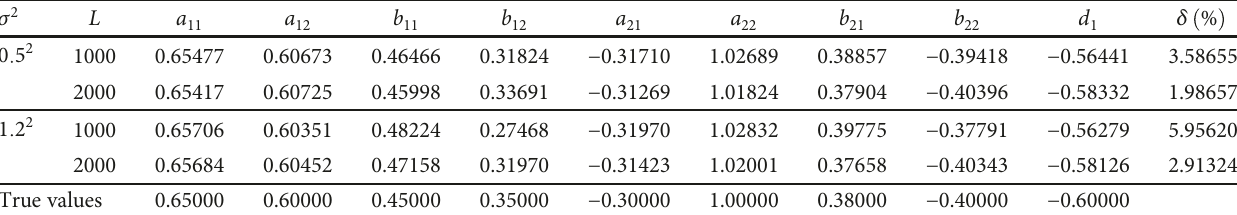
Table 3: The F-GI parameter estimates and errors ( k = 500